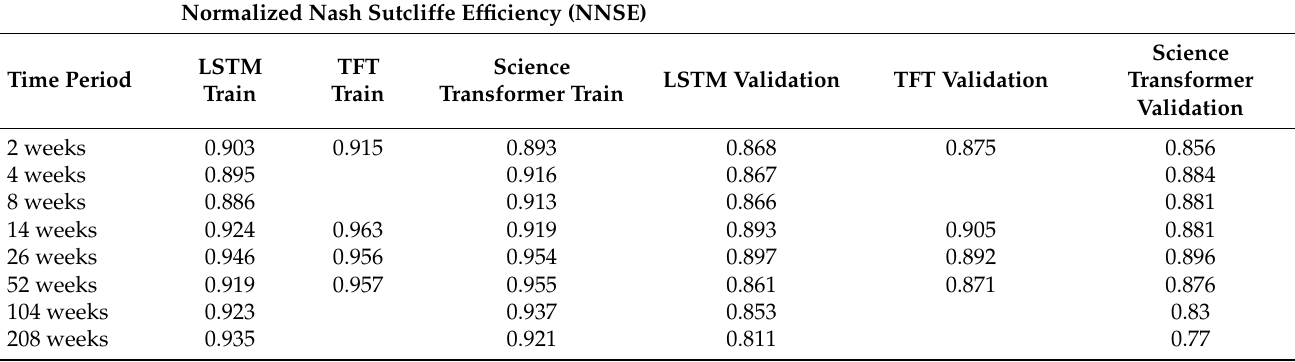
Table 6. Summary of nowcasting results in terms of predicted Nash Sutcliffe